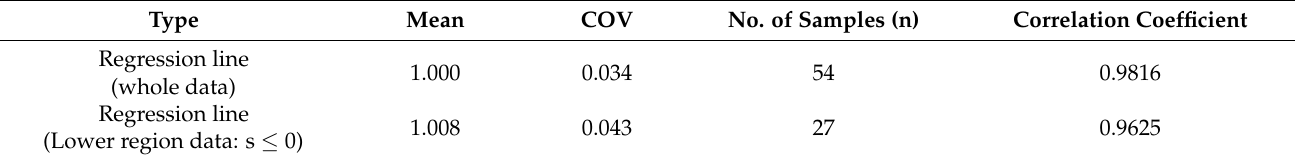
Figure 7. Plot of experimental results on a normal PDF paper. Table 19. Probabilistic characteristics of 4-rib experimental data.